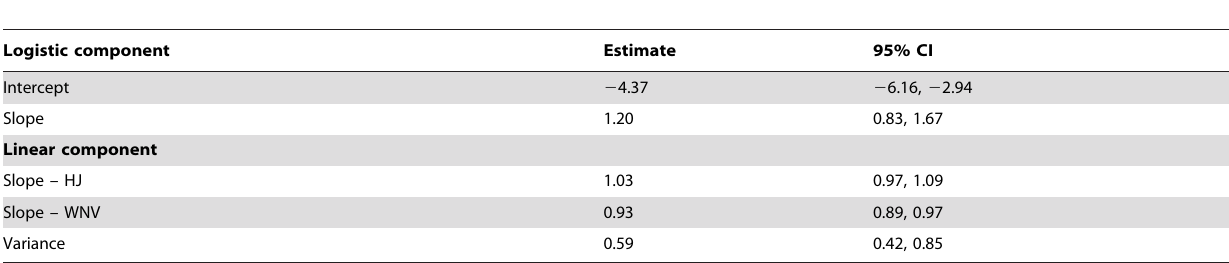
Table 3. Parameter estimates and 95% confidence intervals for the final model relating mosquito-measured and syringe-measured